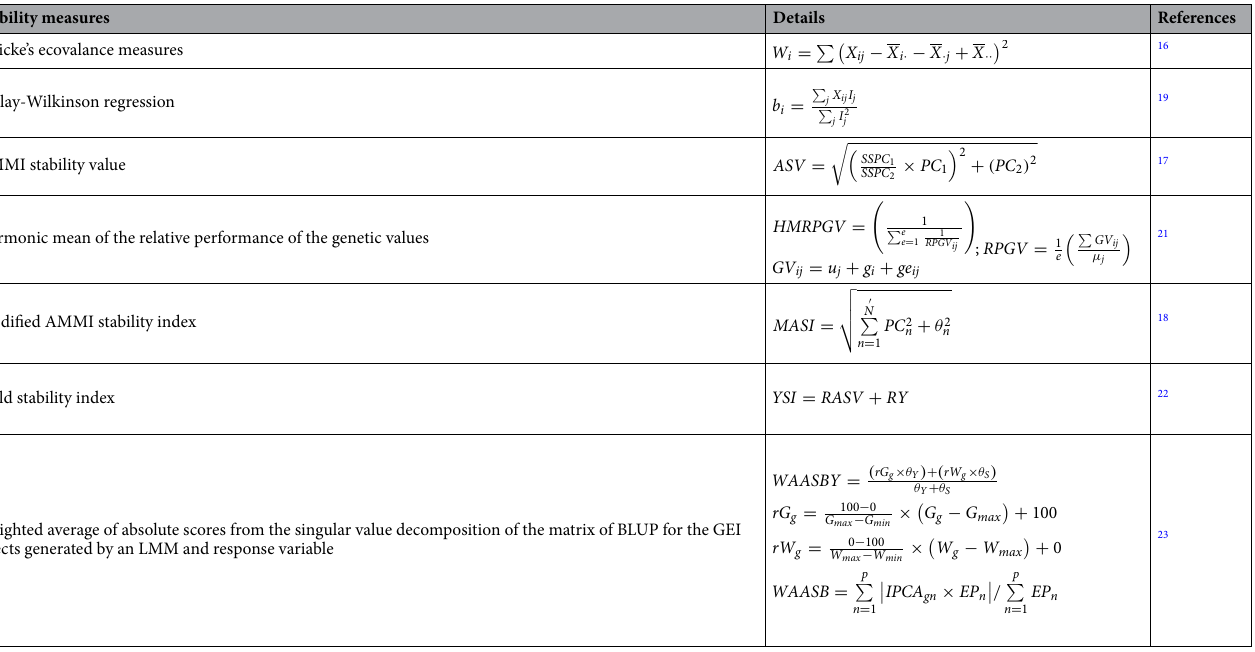
Table 6. Description of the stability statistics studied. g : number of genotypes, e : number of environments, X ij : average yield of genotype i in environment j , X i · : average yield of the genotype i , X · j : average yield of the environment j , X ·· : grand average yield, Ij : Environmental index, which is the deviation of the average of all genotypes in a specific place from the total average, PC : interaction principal components, SSPC n : sum of squares of the n th PC, GV ij : genotypic value of genotype i in environment j , u j : represents the mean of environment j , g i and ge ij are the BLUP values of genotype i and the interaction between genotype i and or environment j , respectively, θ n : the percentage sum of squares explained by the nth principal component interaction effect, RASV : rank of AMMI stability value, RY : rank of the mean yield of genotypes across environments, μ j : general mean for each environment j , IPCA gn is the score of the genotype g in the n th IPCA, and EP n is the amount of the variance explained by the n th IPCA. θ Y and θ S are the weights for yield and stability, respectively. rG g and rW g are the rescaled values of the g th genotype for yield and WAASB, respectively, G g and W g are the yield and WAASB values for g th genotype,